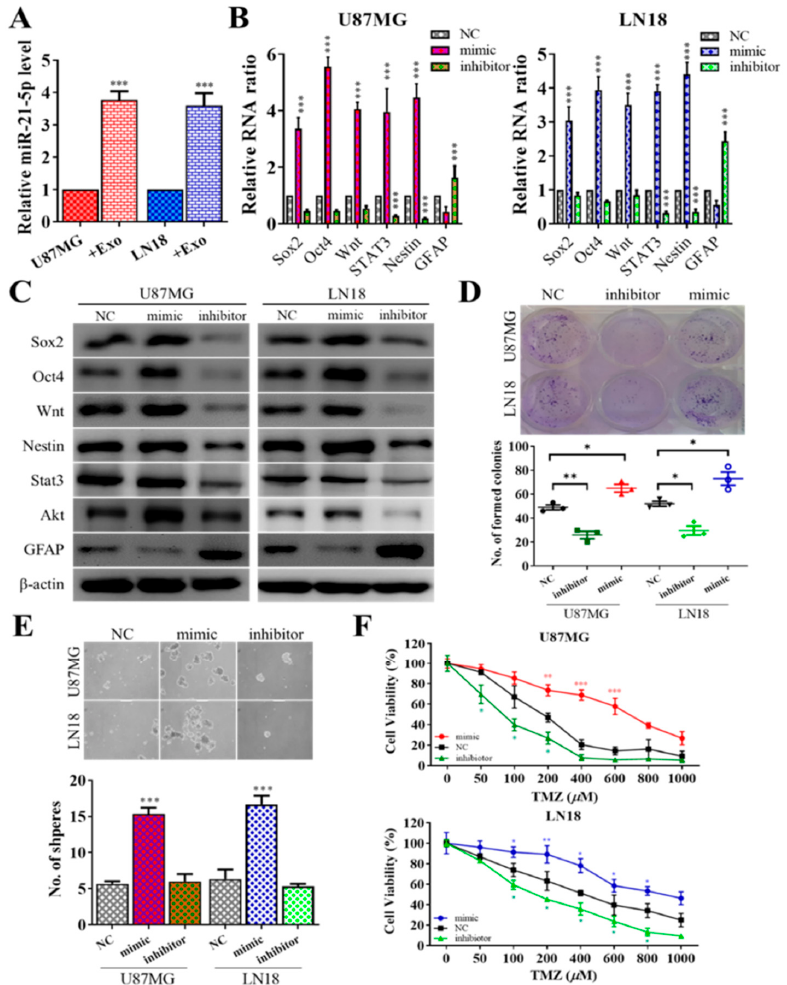
Figure 3. GAM-derived exosomes promoted GBM tumorigenesis via miR-21-5p. ( A ) U87MG and LN18 cells incubated with GAM-derived exosomes showed a significantly increased level of